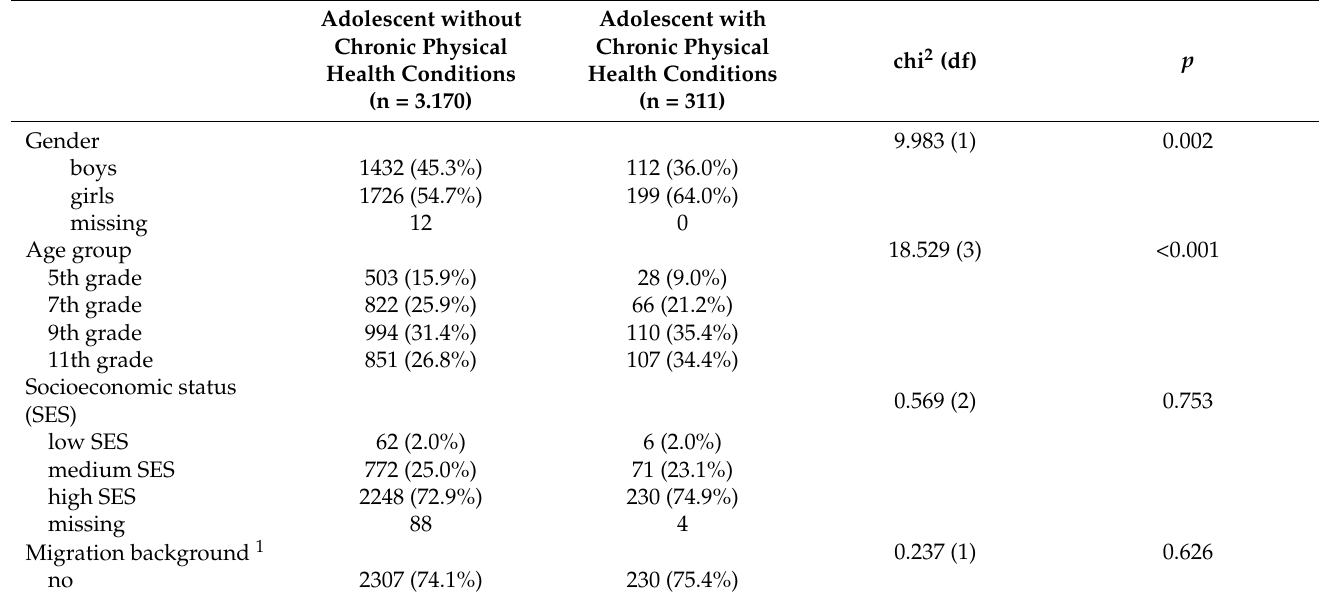
Table 2. Sociodemographic characteristics in adolescents with and without a chronic physical health